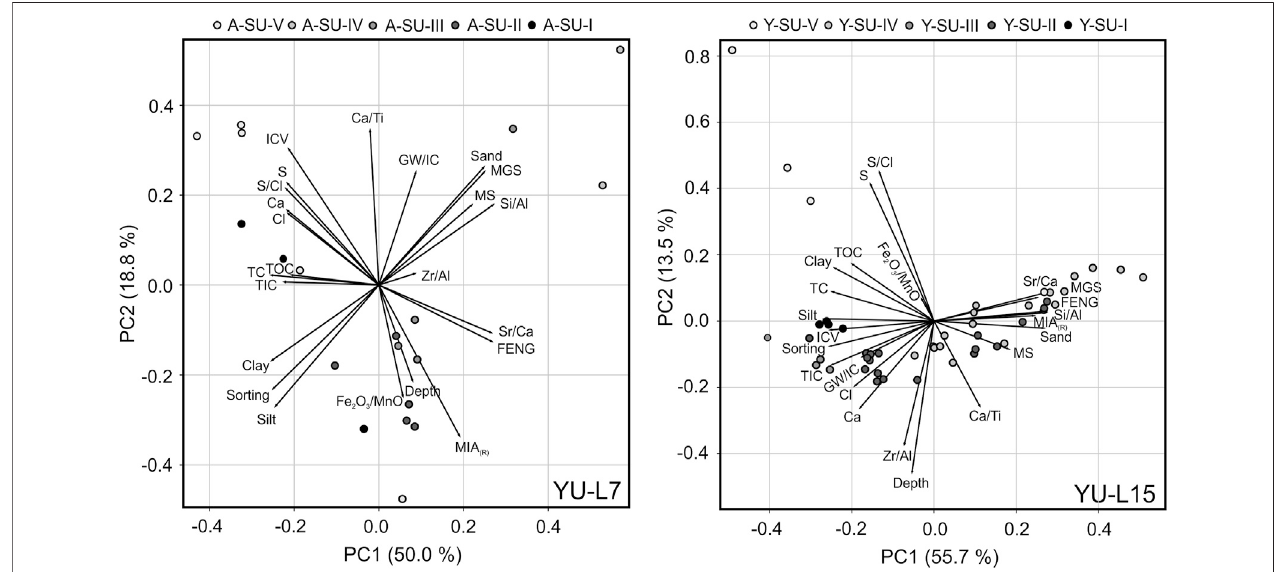
FIGURE9| PCA ordinationbiplotsonallsedimentological andbiogeochemicalparametersfor (A) thealaslakecoreYU-L7and (B) theYedomalakecoreYU-L15. The sample scores are scaled in white, gray and black according to the sediment units given above the plots.